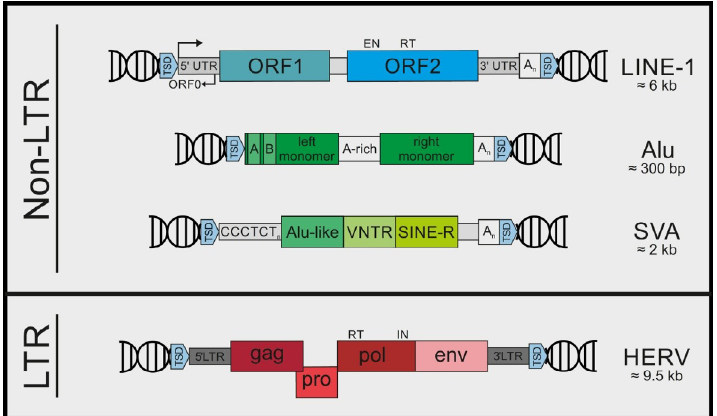
Figure 1. Retroelements are classified as LTR and non-LTR elements according to their structures. Non-LTR retroelements include LINE-1, Alu , and SVA (SINE-VNTR- Alu ) elements. LTR retroelements mainly include HERVs. TSD: target site